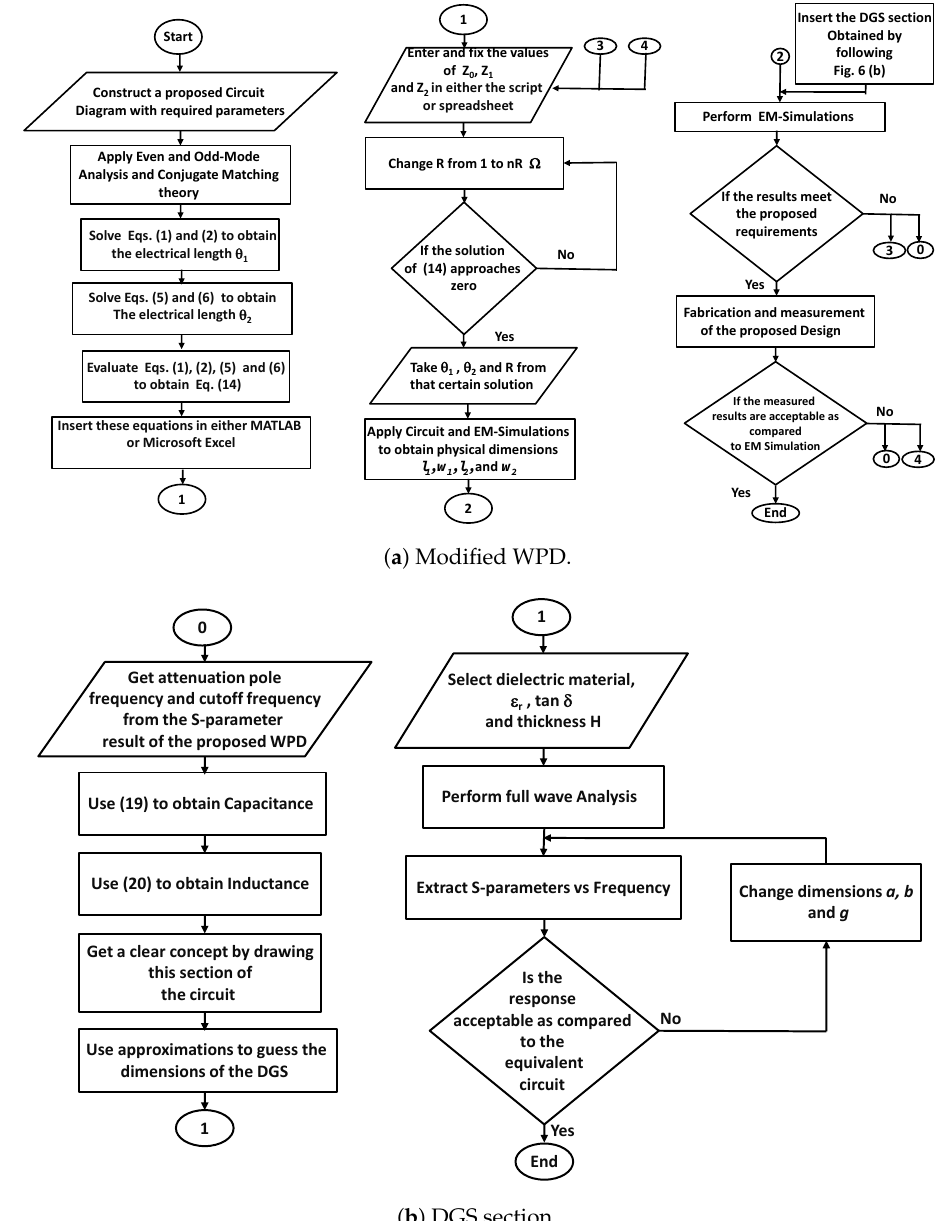
Figure 6. Design flow of the proposed